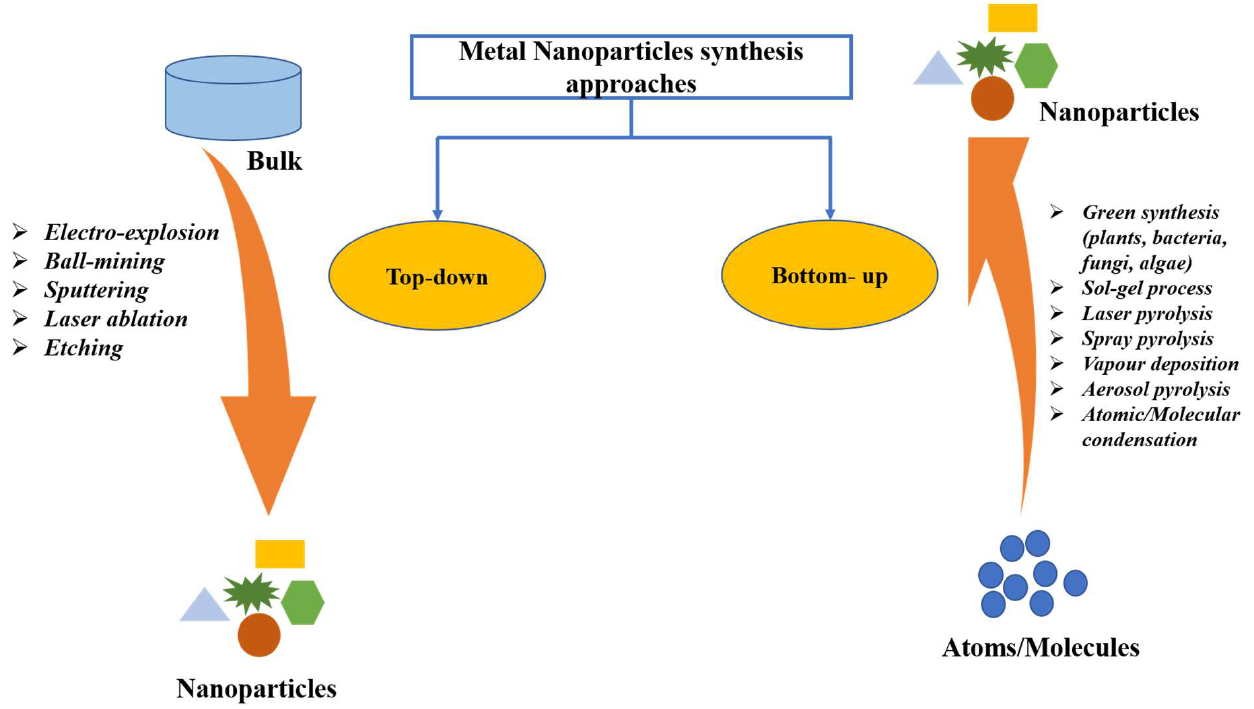
Figure 1. Different approaches of metal nanoparticles synthesis.